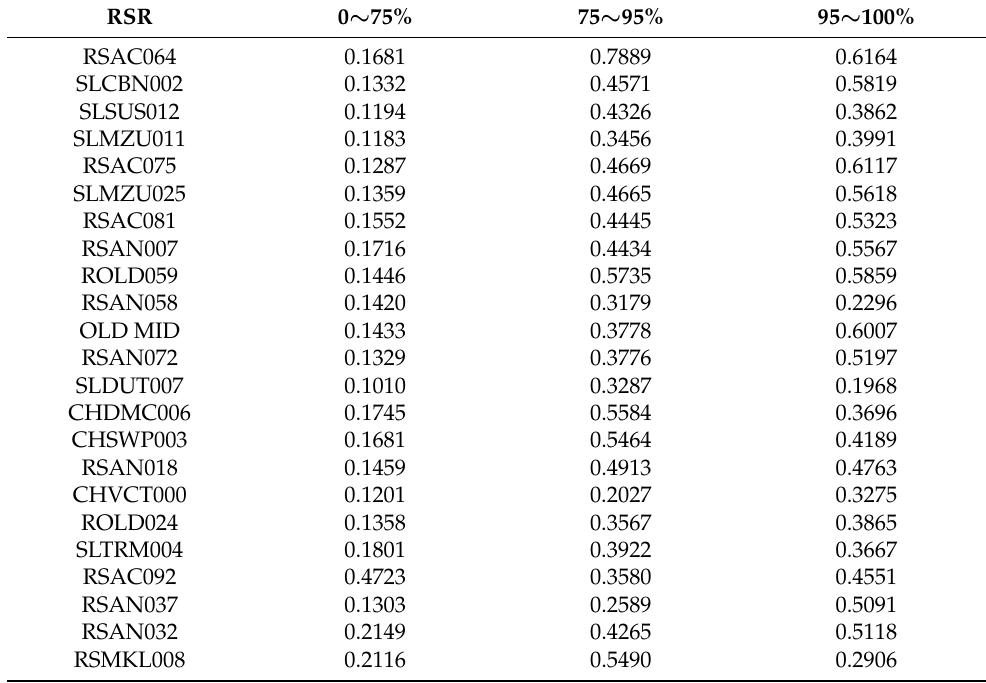
Table A8. Station-wise RSR results of Res-LSTM at daily time